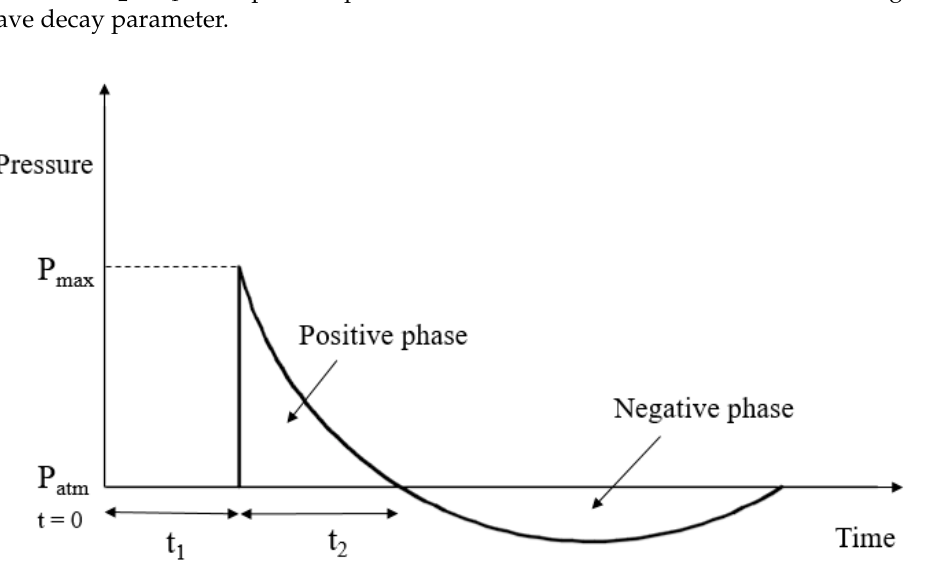
Figure 17. Variation of pressure with time: t 0 is the time of detonation and t 1 is the time of arrival. The variation of temperature due to the explosion is not considered in this study and the pressure-time history is applied to the column using the Conventional Weapons Model (CONWEP) built-in ABAQUS [17]. The model introduced by Kingery and Bulmash [31] calculates the pressure at each time step for all nodes in the predefined target surface using Equation (1). The charge amount is defined in equivalent TNT and the explosion source is selected by the user before the analysis. The program calculates the decay coefficient, correct distance, and angles of incidence based on the input